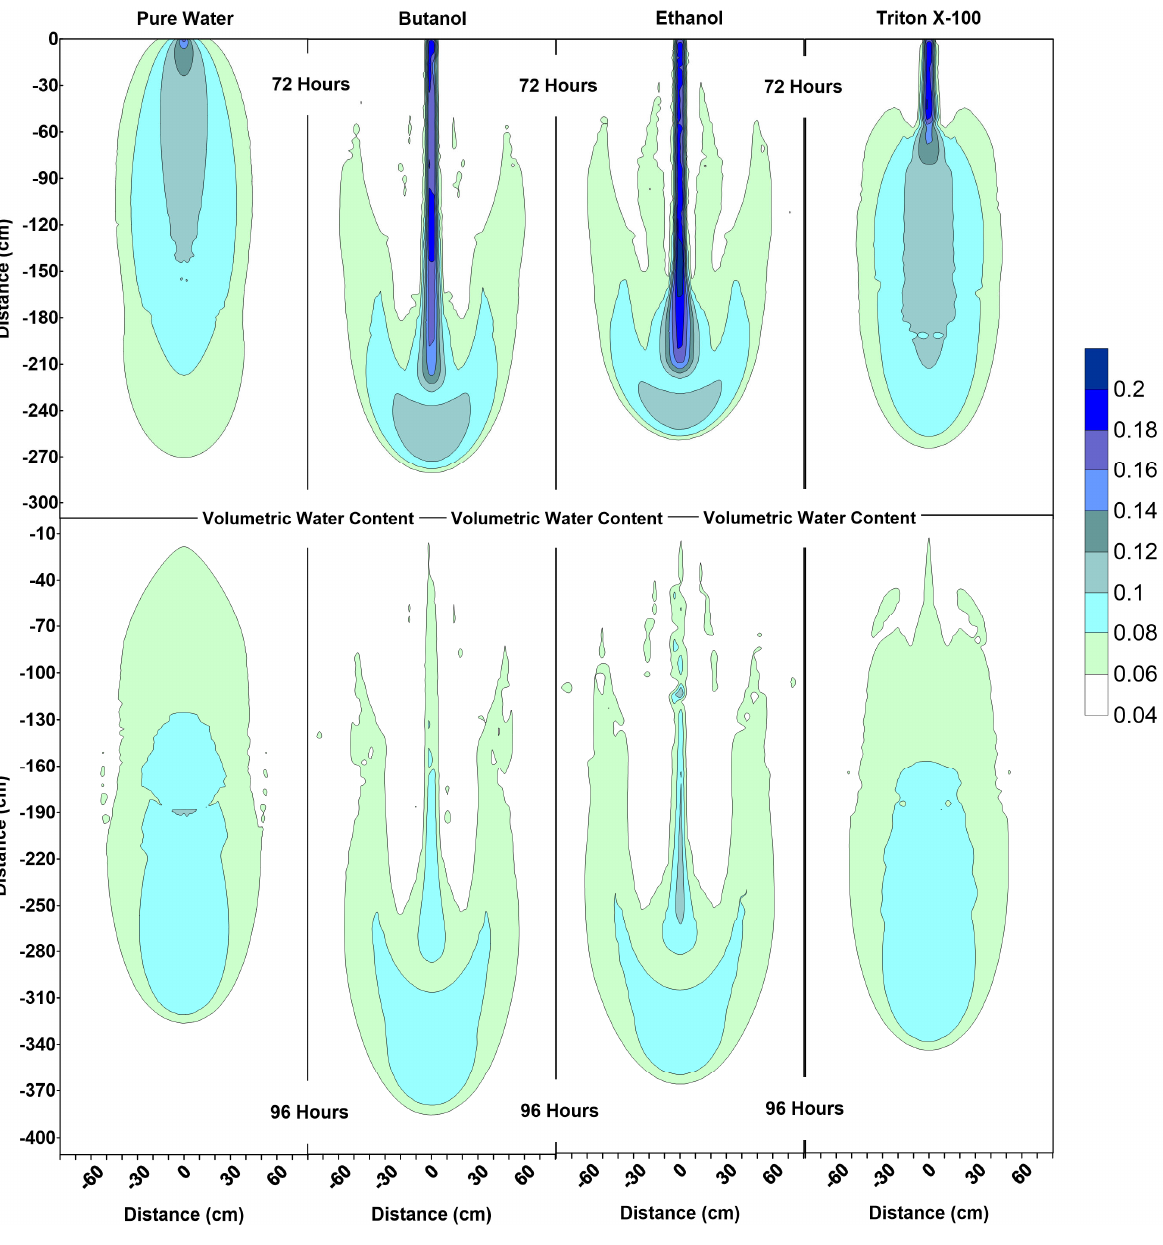
Figure 6. Volumetric water content profiles at 72 h and 96 h for pure water, butanol, ethanol and Triton X ‐ 100 solutions.